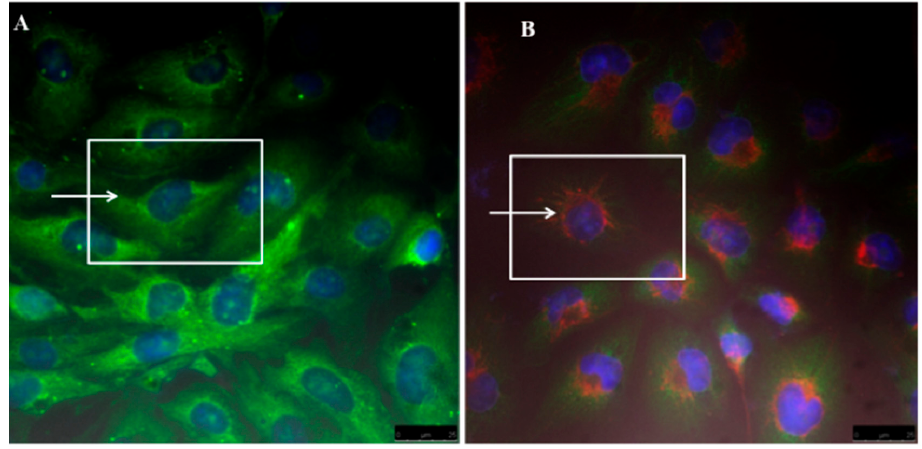
Figure 8. Confocal laser scanning fluorescence microscopy images of SMA (green) and Micelles (Red). ( A ) Control HLF (without LY-loaded micelles); ( B ) HLF incubated with encapsulated LY. (Scale bar: 25 µm) (Arrows and square indicate nanomicelles uptake).